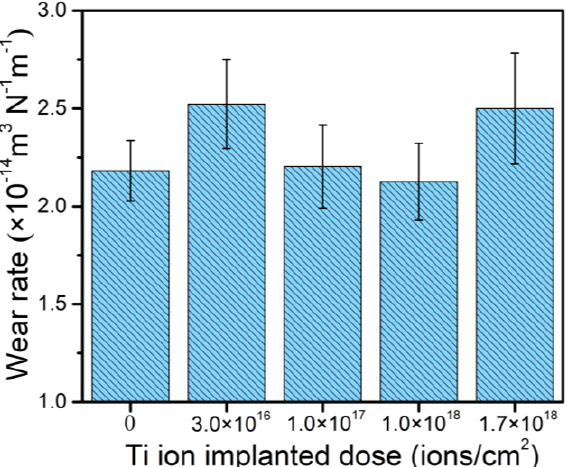
Figure 8. Wear rate of 316L stainless steel samples with different Ti ion implantation doses.